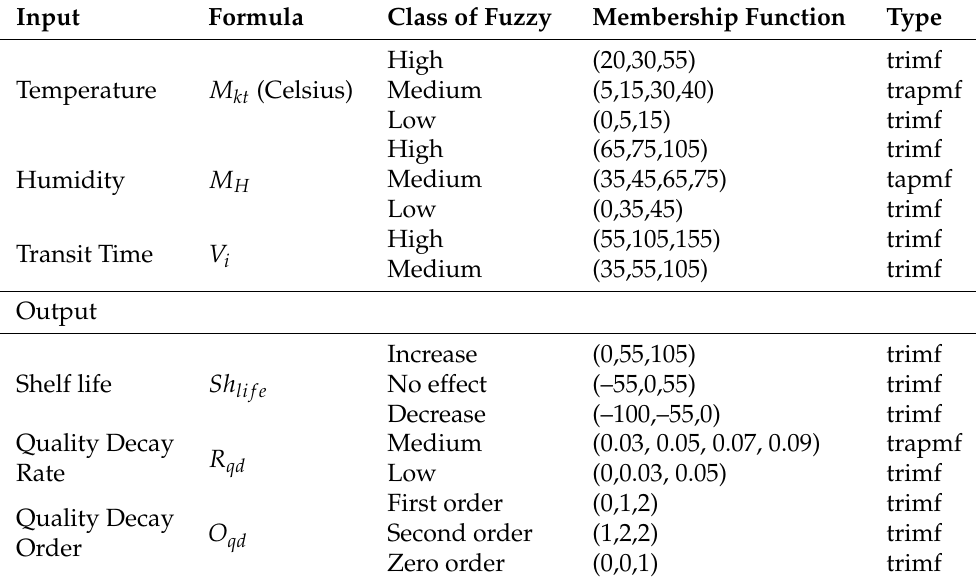
Table 3. Fuzzy logic membership function on food traceability